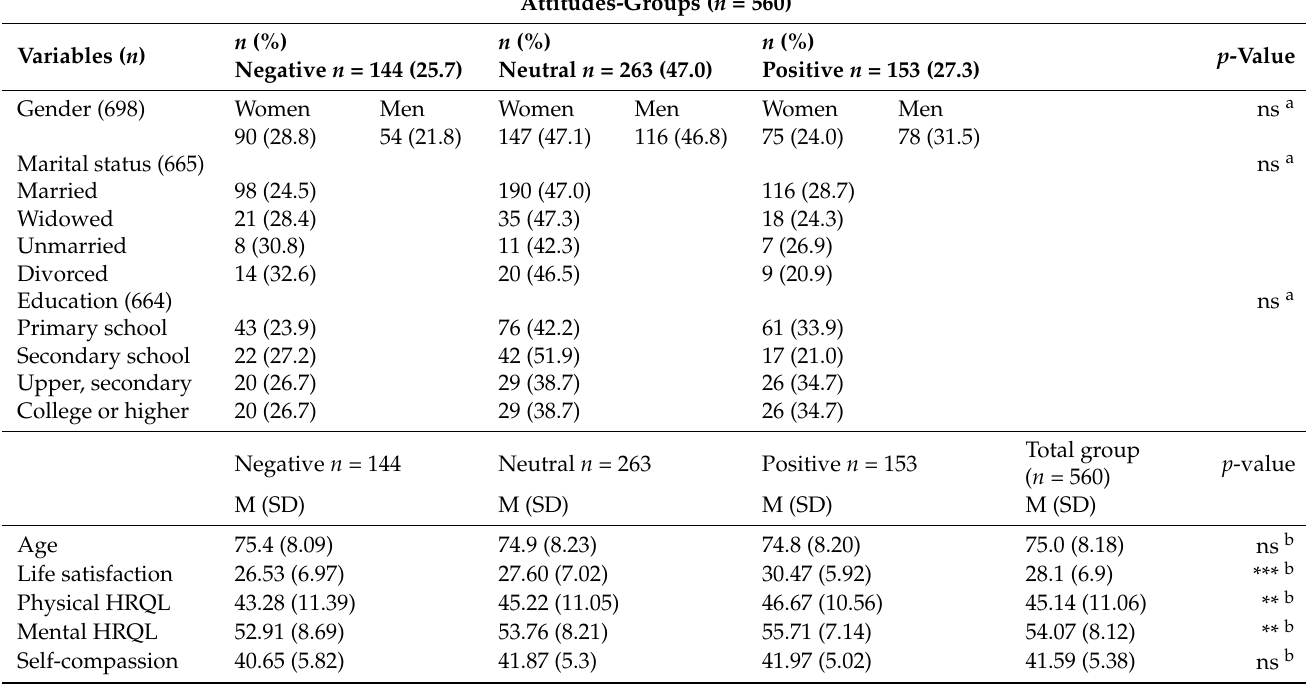
Table 1. Sociodemographic characteristics and mean differences by